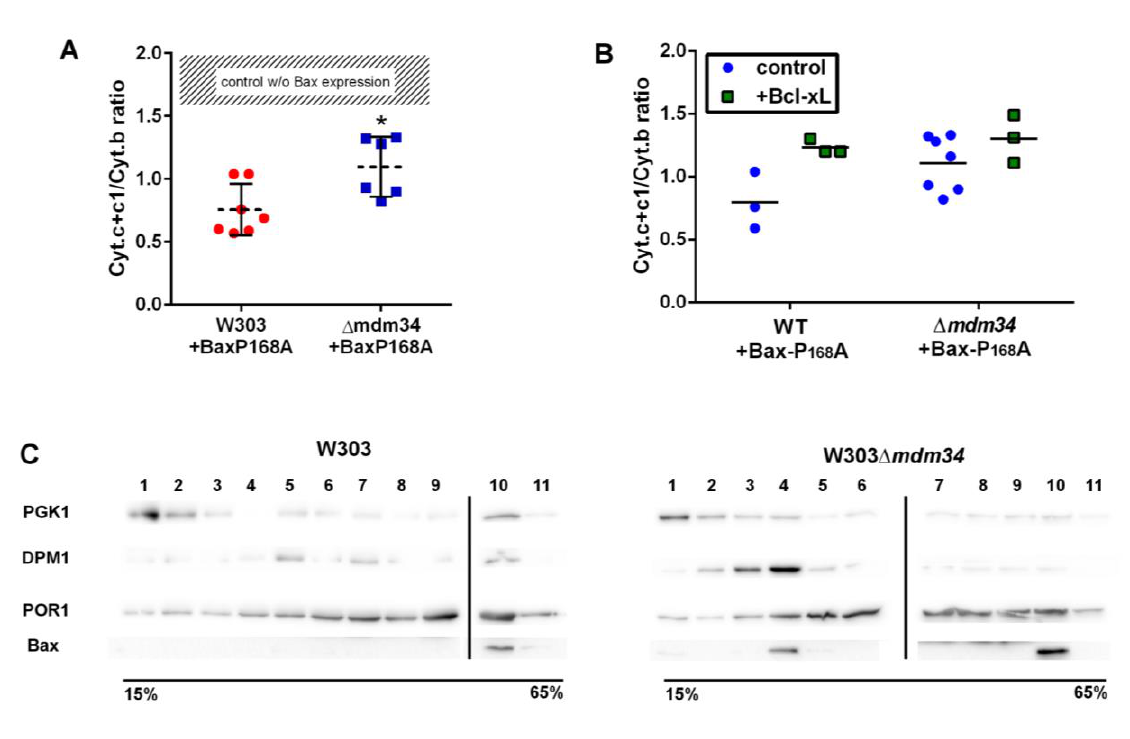
FIGURE 2: Bax-P168A is partly retained in ER, and has a decreased ability to release cytochrome c in Δ mdm34 cells. (A) Cytochrome c+c1/Cytochrome b ratios measured on mitochondria isolated from wild-type or Δ mdm34 cells expressing Bax-P168A. Each point repre- sents a single mitochondria preparation. The hatched zone corresponds to the typical values found on mitochondria preparations from cells that do not express Bax [27-39]. *: p<0.05 (unpaired Student t-test). (B) Cytochrome c+c1/Cytochrome b ratios measured on mito- chondria preparations isolated from strains co-expressing Bax-P168A and Bcl-xL. (C) Separation of whole extracts from cells expressing Bax-P168A on a 15-65% sucrose density gradient. Vertical lines mark the separation between different gels. Data are representative of four independent